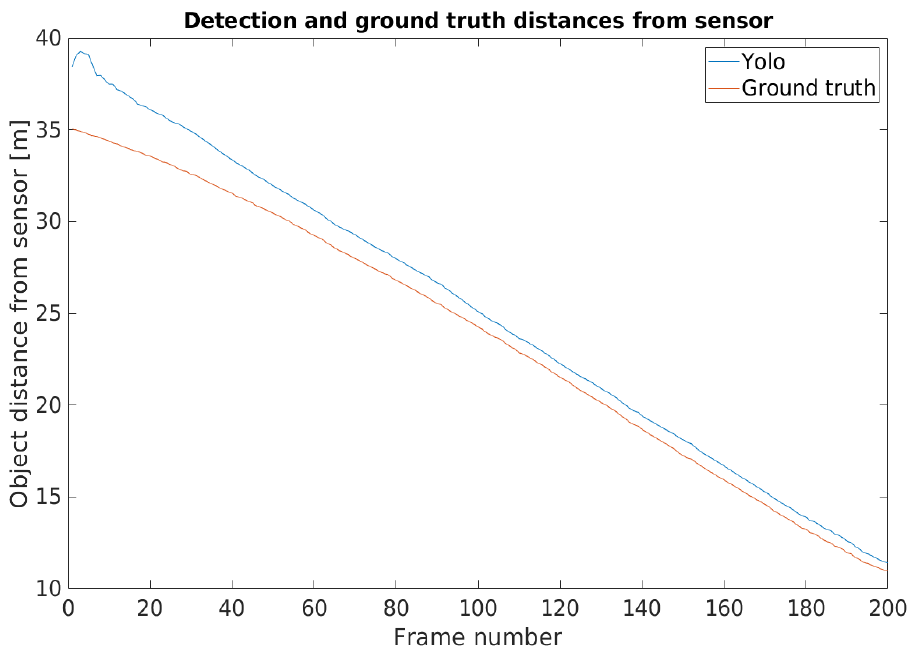
Figure 34. Positions relative to the